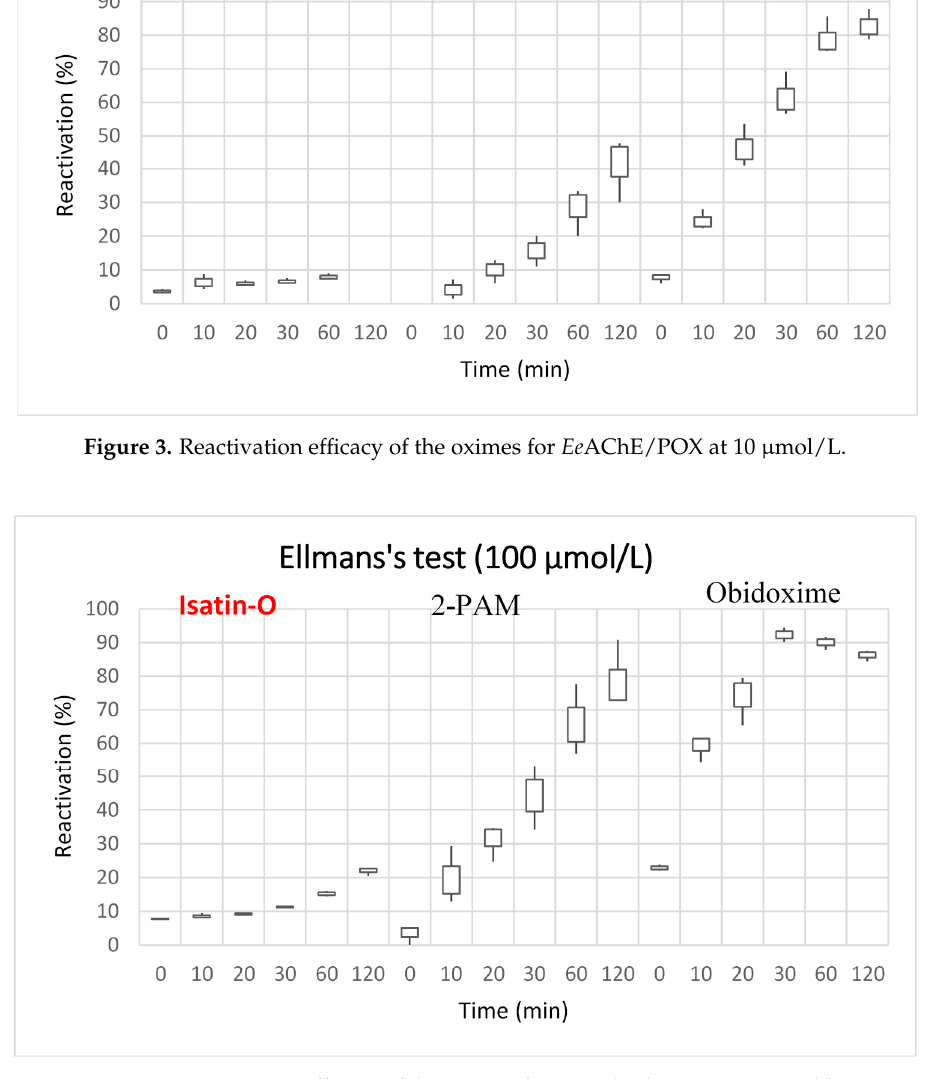
Figure 4. Reactivation efficacy of the oximes for Ee AChE/POX at 100 μ mol/L.